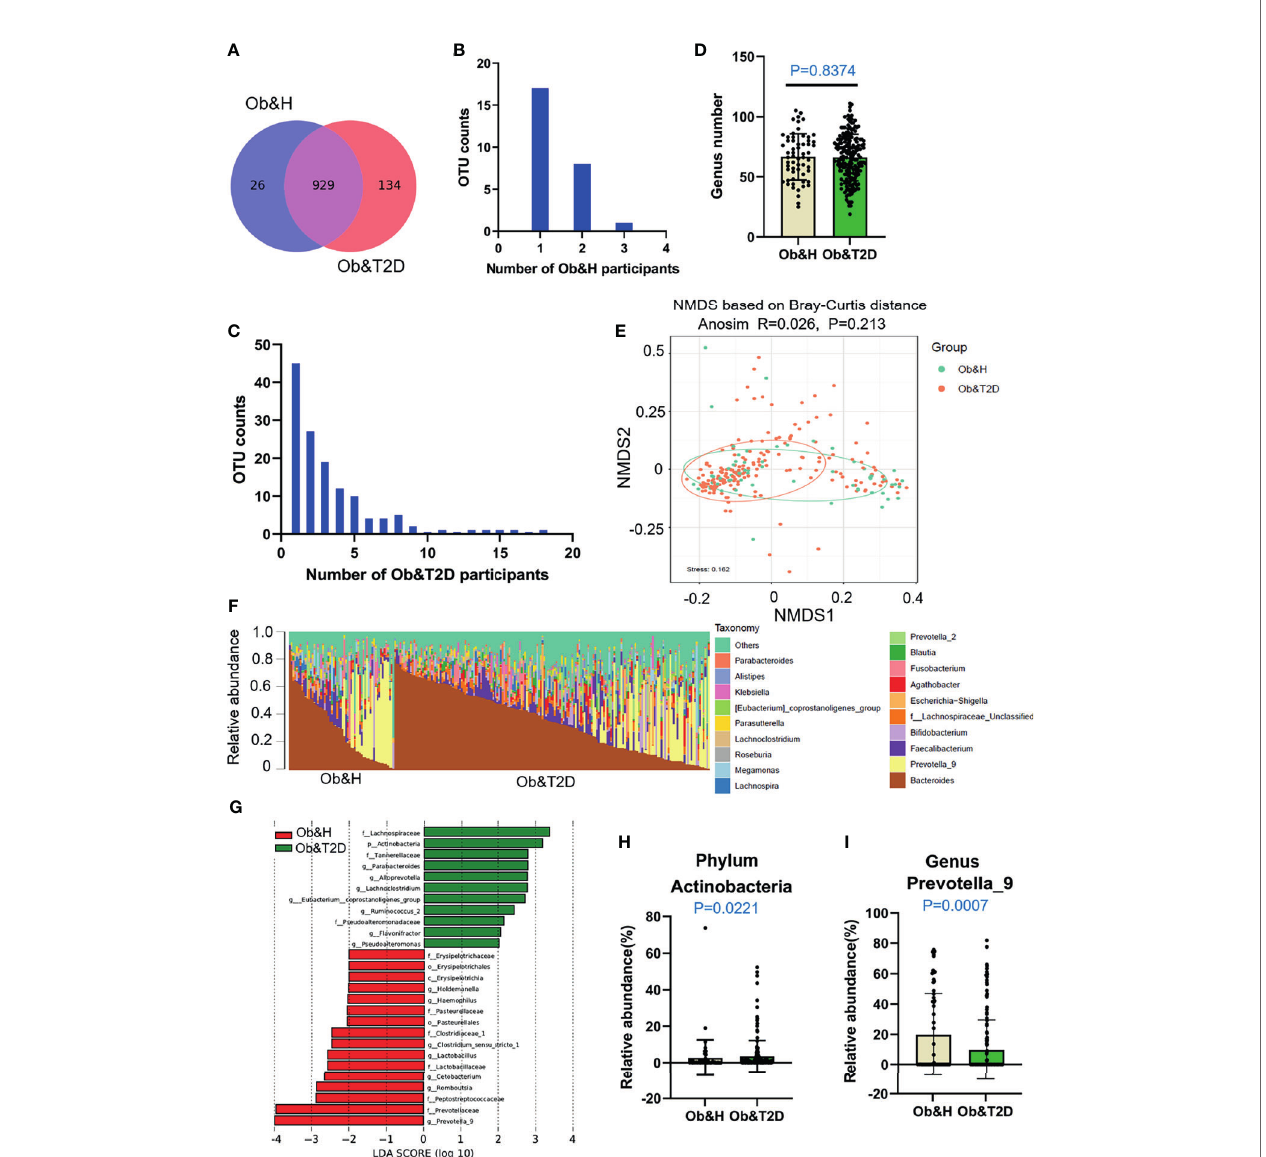
FIGURE 2 | Differential gut microbiota analysis of obese and healthy (Ob&H) and obese and type 2 diabetes (Ob&T2D) patients. (A) Venn diagram of the observed operational taxonomic units (OTUs) in Ob&H and Ob&T2D. (B, C) Frequency distributions of the 26 Ob&H- (B) and 134 Ob&T2D-speci fi c OTUs (C) in the study participants. (D) Estimate of richness analysis between the two groups at the genus level. Data are shown as means ± SD. (E) Nonmetric multidimensional scaling analysis of the gut microbiota based on the Bray – Curtis distance for Ob&H and Ob&T2D, ANOSIM, R = 0.026, P = 0.213. (F) Genus-level taxonomic abundances for gut 16S rRNA gene sequencing data. The top 20 abundant genera are annotated in the panel legend. Samples are ordered according to decreasing relative abundance of Bacteroides in the Ob&H and Ob&T2D groups. (G) Linear discriminant analysis (LDA) scores for the gut bacterial taxa differentially abundant between Ob&H and Ob&T2D. Red bars with LDA score greater than 2 indicate that the taxa were enriched in Ob&H, and green bars with LDA score greater than 2 indicate that the taxa were enriched in Ob&T2D. (H, I) Relative abundance of phylum Actinobacteria (H) and genus Prevotella_9 (I) in Ob&H and Ob&T2D. Data are shown as means ± SD. All P- values are from Wilcoxon rank-sum